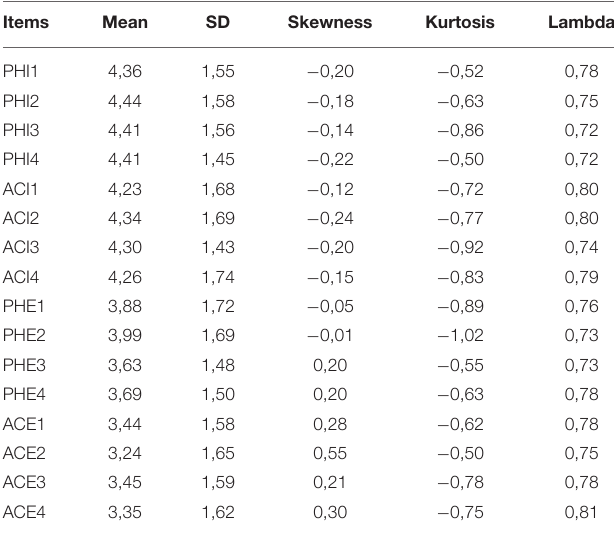
TABLE 2 | Descriptive statistics, normality test, and factor loadings of exploratory factor